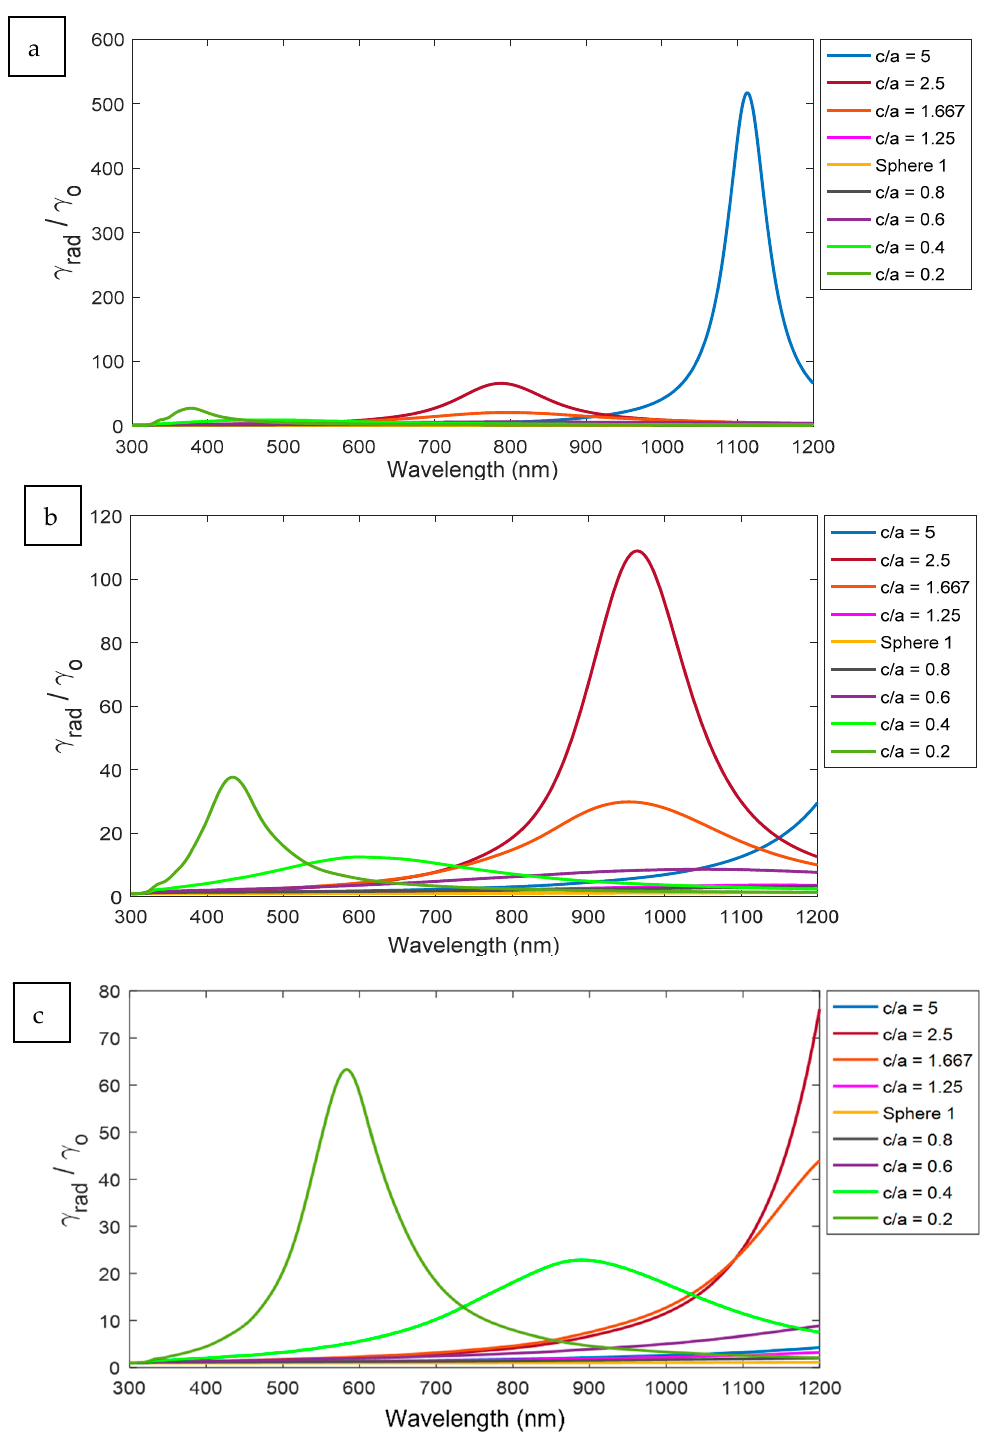
Figure 7. The radiative decay rate γ rad in a different aspect ratio c/a in different distances ( a ) d = 5, ( b ) d = 10, and ( c ) d = 20 nm.